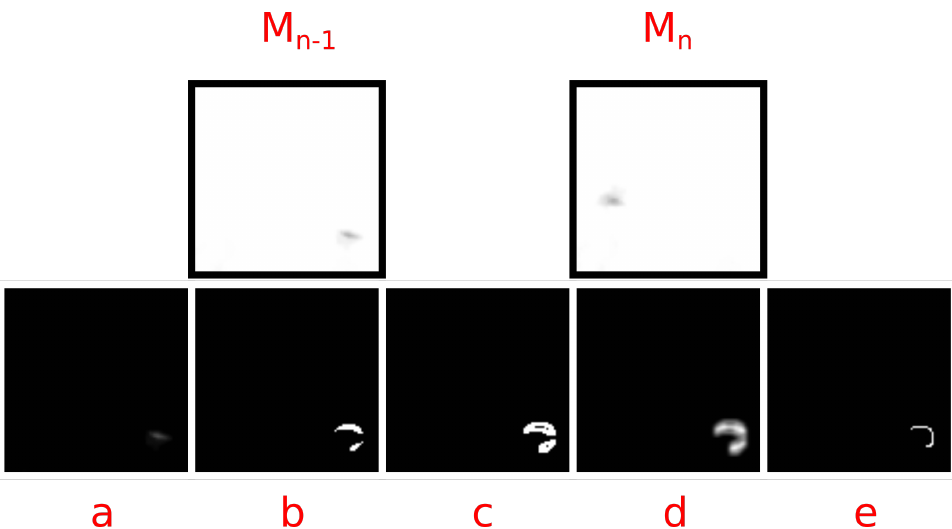
Figure 1. This image demonstrates a stepwise operation of the UnCanny filter comparing the current frame M n to the previous frame M n − 1 . The images were ( a ) subtracted, ( b ) thresholded and blurred, ( c ) distanced after Sobel operation, ( d ) blurred, and ( e )